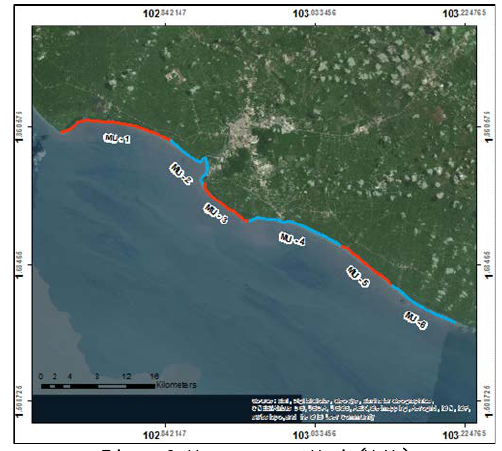
Figure 9. Management Unit (MU)